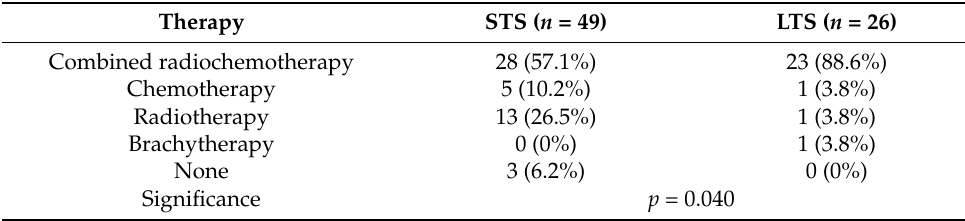
Table 2. Differences between STS and LTS: initial therapy.